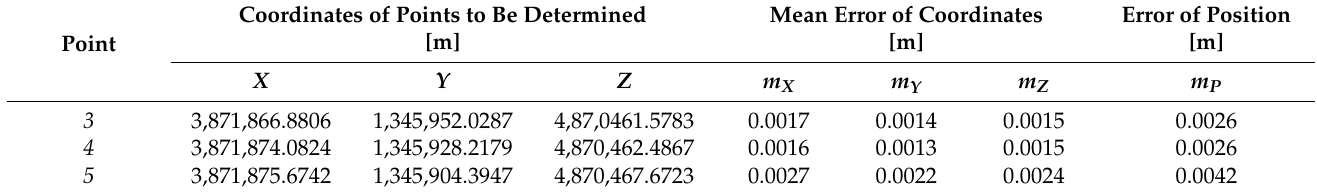
Table 6. Adjusted coordinates and mean errors (GNSS vector network).